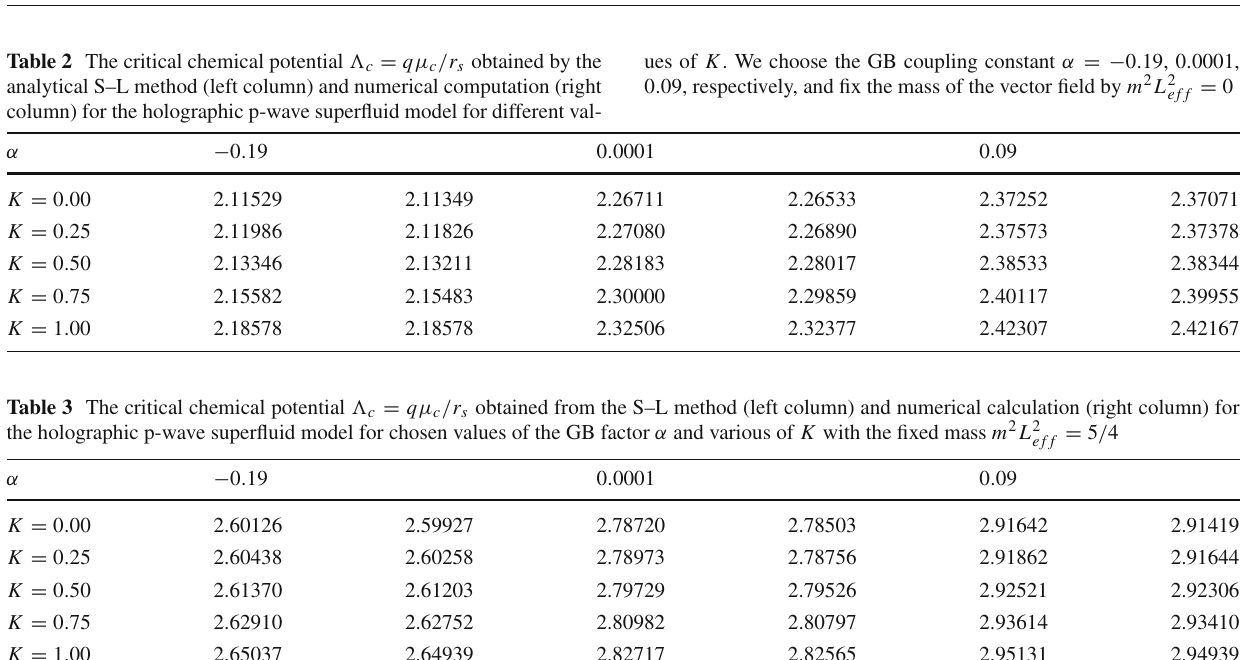
ues of K . We choose the GB coupling constant α = − 0 . 19, 0 . 0001, 0 . 09, respectively, and fix the mass of the vector field by m 2 L 2